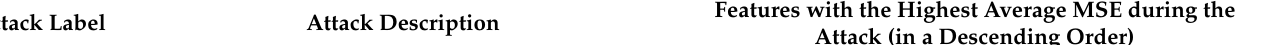
Table 3. Attack localization for the test set ( Dataset 3) of BATADAL. Components in bold correspond to the directly attacked components.